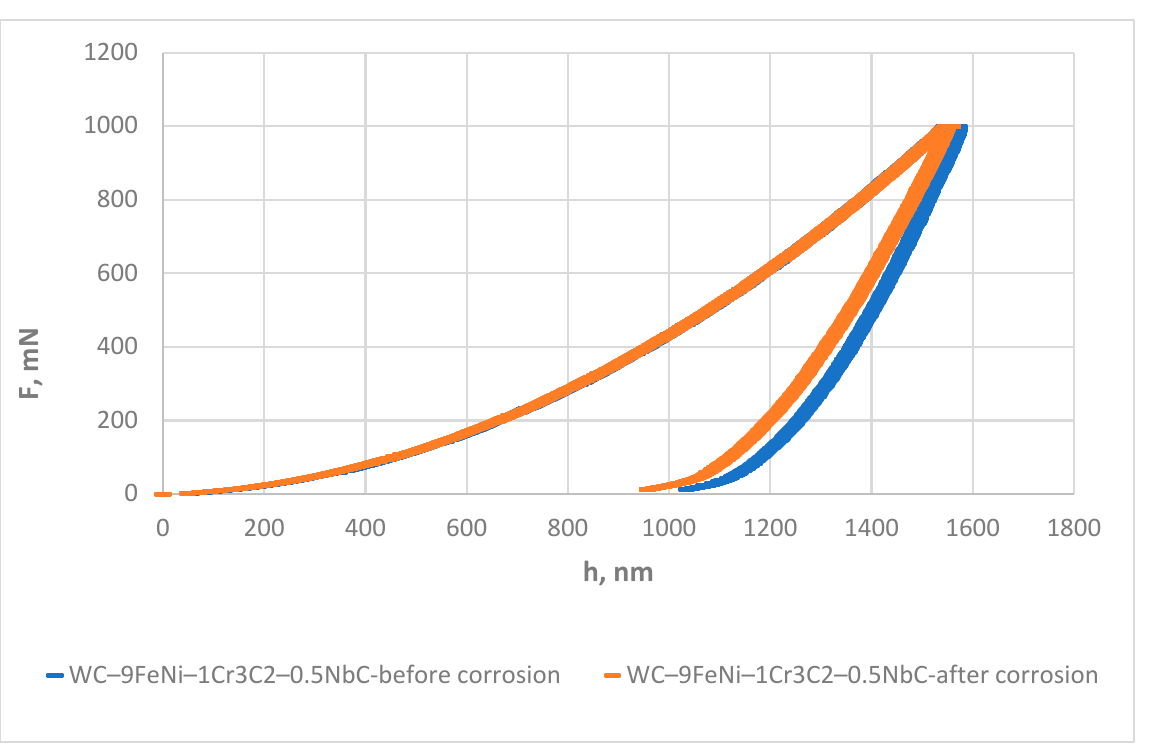
Figure 15. Force-depth diagrams of WC–9FeNi–1Cr 3 C 2 –0.5NbC samples before and after corrosion. The force-depth curve is shifted to the left for the WC–9FeNi–1Cr 3 C 2 –0.5NbC sample after corrosion, which indicates a decrease in the total work, represented by the area under the curve. The slope of the loading curve is equal for both samples, before and